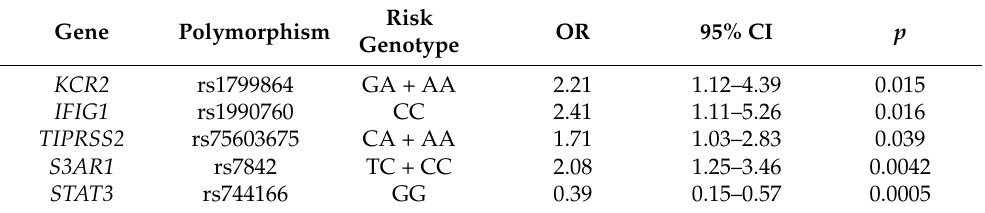
Table 7. Markers associated with susceptibility to disease or clinical manifestations of symptoms (subgroup C1 (healthy + asymptomatic patients) vs. subgroup C2 (symptomatic patients)).